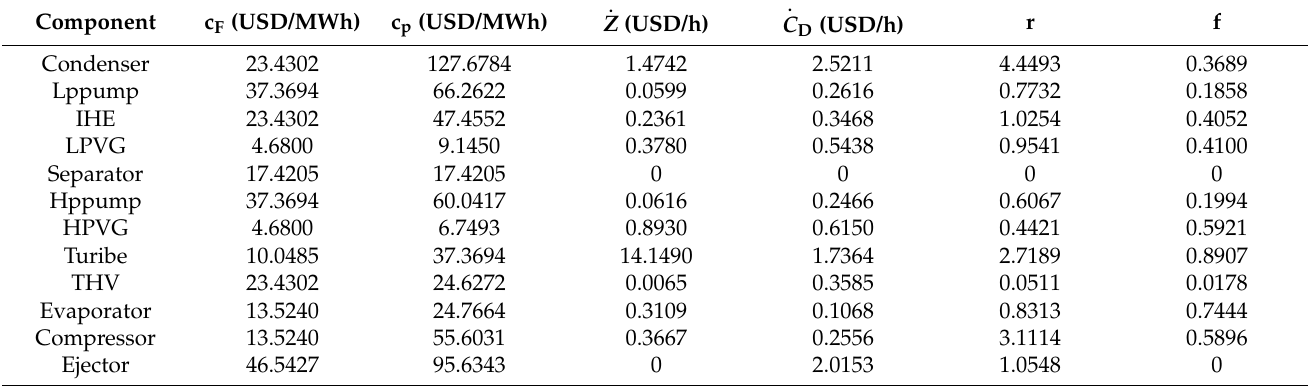
Table 12. Exergoeconomic analysis results of system components.